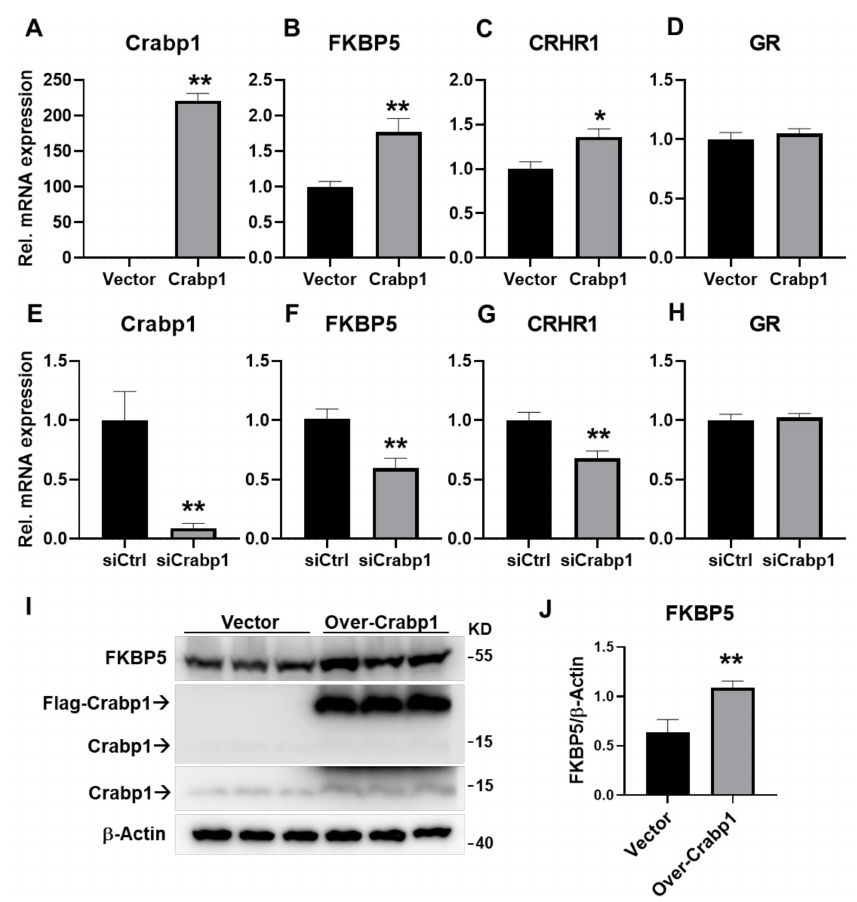
Figure 4. Changes in mRNA levels of Crabp1, FKBP5, CRHR1, and GR and FKBP5 protein levels in AtT20 cells with elevated (over-expression) or lowered (silencing) Crabp1 levels. ( A – D ) mRNA levels of key genes in Crabp1-elevated AtT20 cell ( n = 6/groups). ( E – H ) mRNA levels of key genes in Crabp1-lowered AtT20 cell ( n = 6/groups). ( I , J ) Changes in FKBP5 protein levels upon Crabp1- expression. Labels are indicated as “Vector” = Empty vector control; “Over-Crabp1” = Crabp1 overexpression; “# Crabp1” = endogenous Crabp1 imaged with a short (top) or long exposure time (bottom). β -actin was used as a loading control. Results are presented as means ± SEM, * p ≤ 0.05, ** p ≤ 0.01, compared with the Ctrl